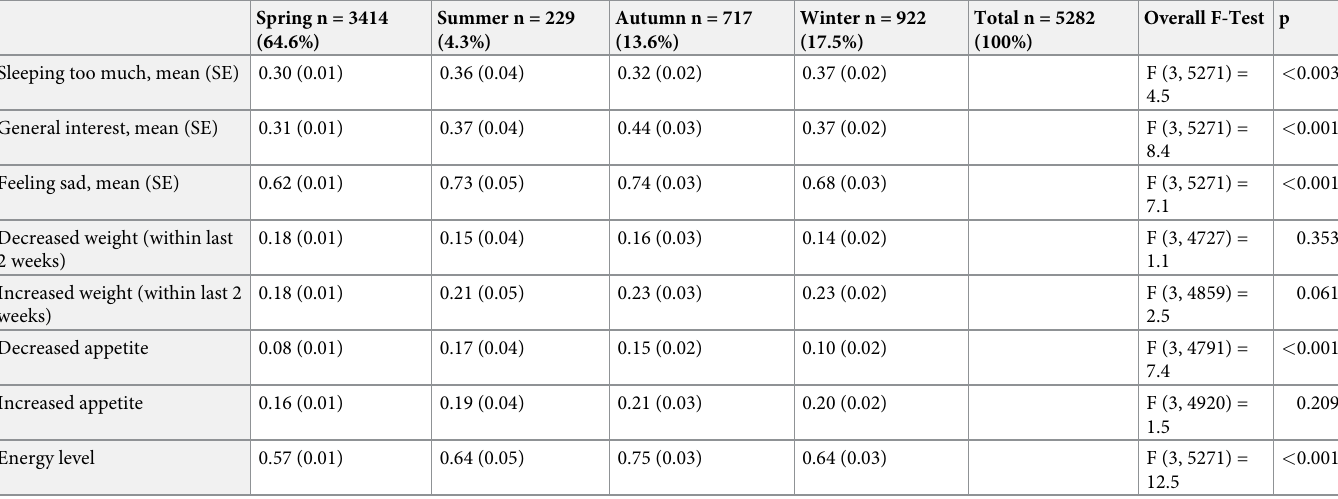
Table 4. Seasonal distribution of symptoms associated with winter depression.